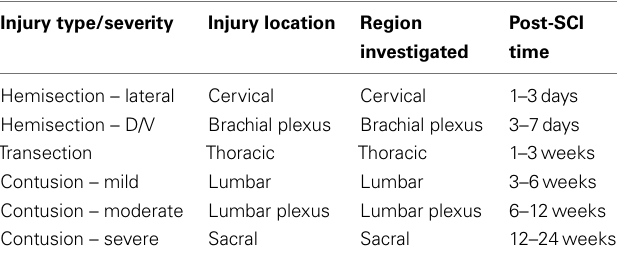
Table 8 | Matrix of factors influencing outcomes in SCI